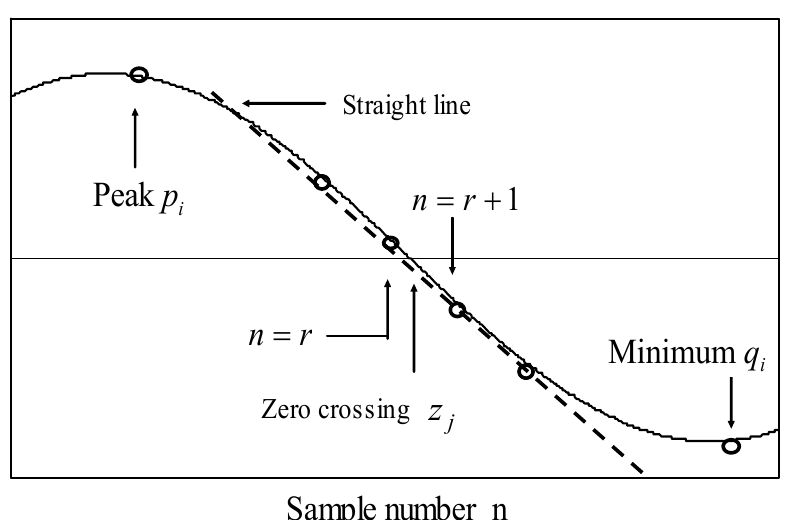
Figure 4. Linear Interpolation and zero crossing.